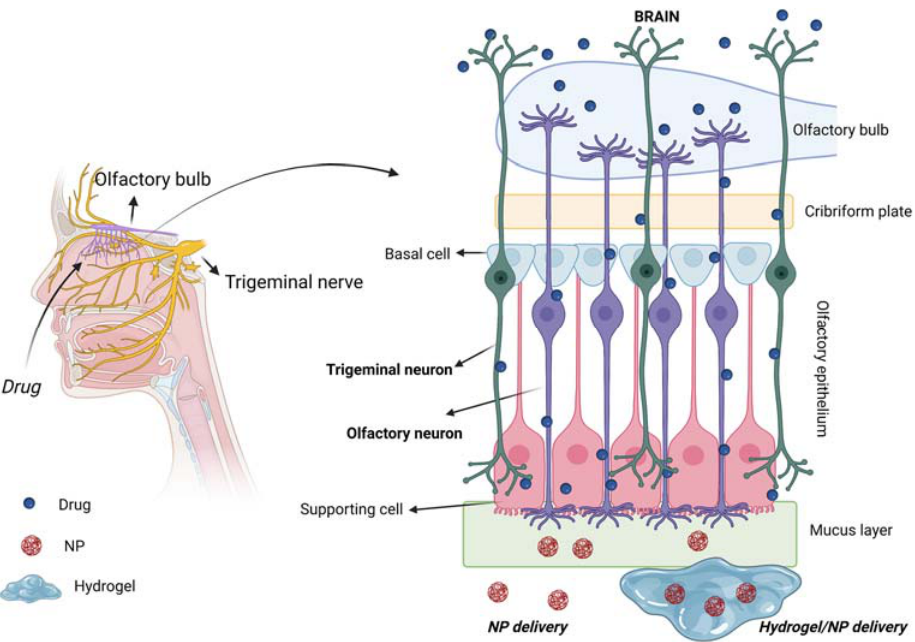
Figure 7. Scheme of IN drug delivery to the brain following the two direct olfactory and trigeminal pathways for drug uptake by the brain. Created with BioRender.com.